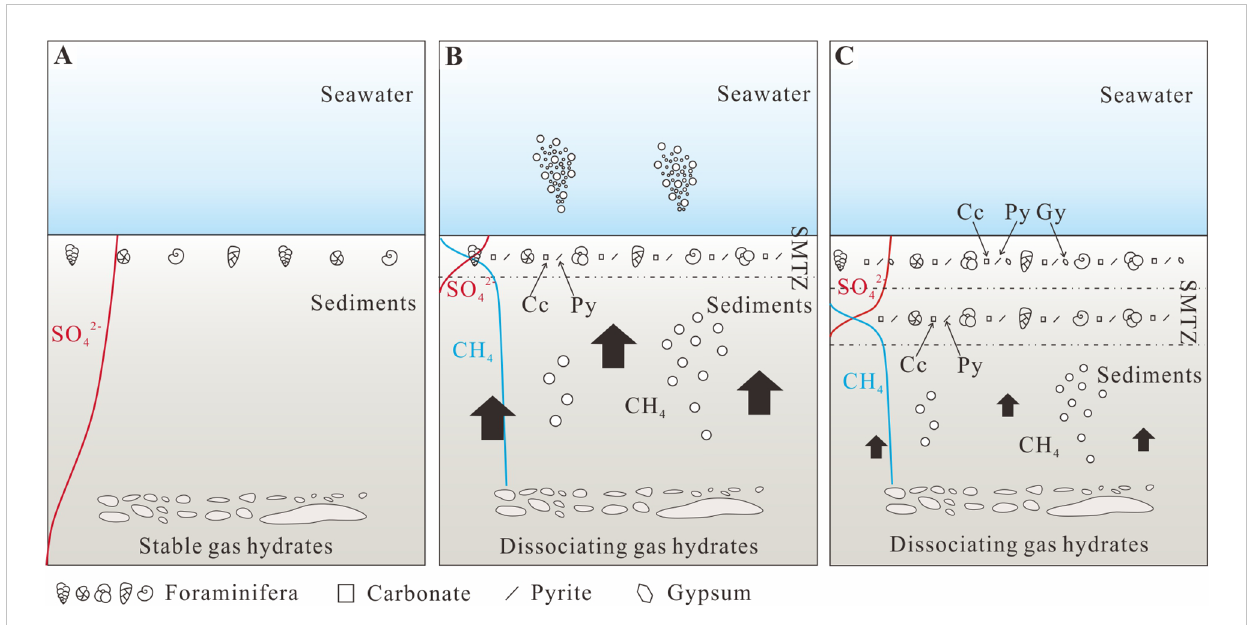
FIGURE 10 Schematic of post-depositional alteration of buried foraminiferal tests in a gas hydrate geosystem (modi fi ed from Kennett et al., 2000). (A) Gas hydrates are in a stable state, and the geochemical compositions of foraminifera record the original signal of the normal marine conditions. (B) During a high methane fl ux event, methane is transported further toward the sediment-water interface, shifting the SMTZ upward and compressing it into the uppermost sediment column. Authigenic carbonates are co-precipitated with pyrite in the SMTZ near the sea fl oor, causing foraminiferal shells buried in this interval to be coated with MDAC, along with some framboidal pyrite interspersed between carbonate crystals. (C) Subsequent reduction of the methane fl ux causes the SMTZ to migrate back downward within the sediment column. Authigenic pyrite and carbonate form in the active SMTZ, whereas pyrite precipitated in the upper part of the sediment column before the downward SMTZ shift are converted to authigenic gypsum through anaerobic pyrite oxidation, which also leaves traces on foraminiferal shells. Cc, carbonate; Py, pyrite; Gy,